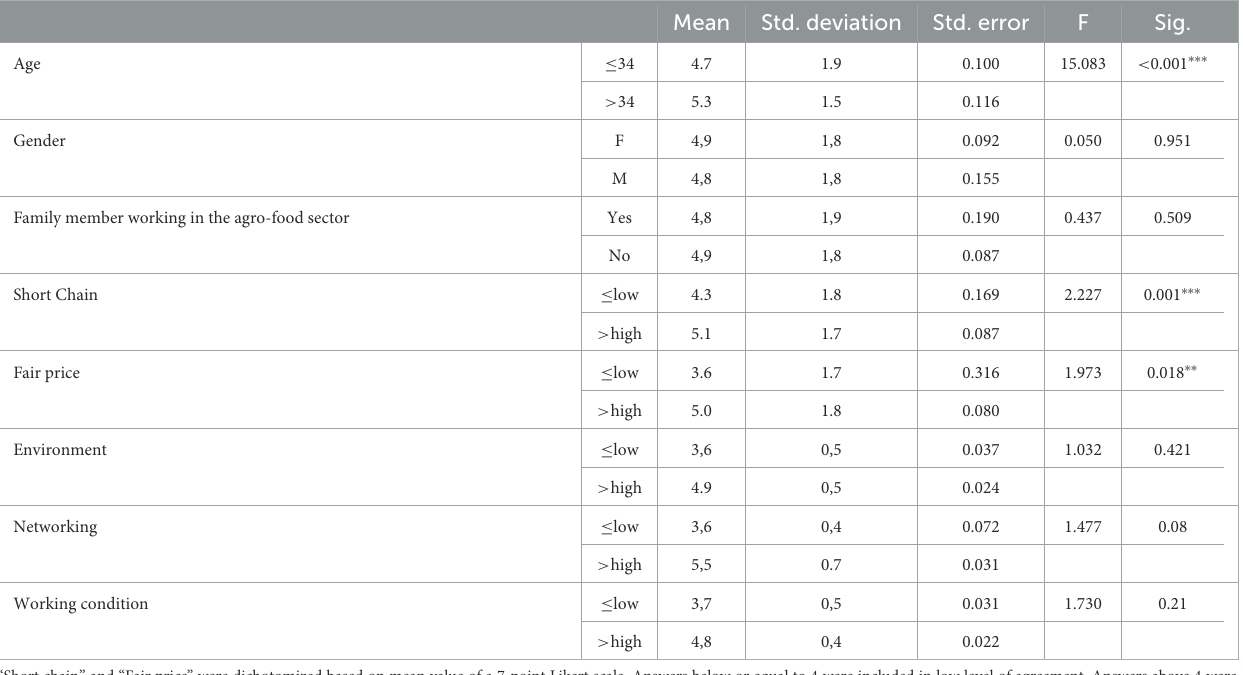
TABLE 5 Influence of socio-demographic characteristics and perceptions of fairness on perceived importance of ’fair price for farmers’ attribute. Mean Std.